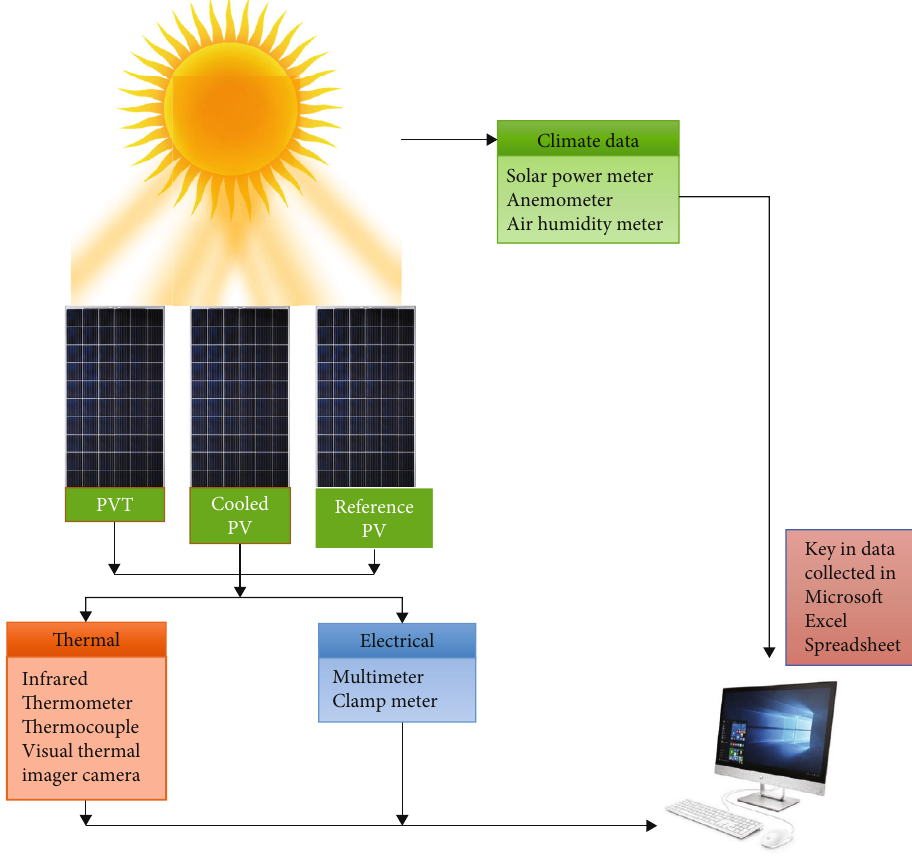
Figure 3: Schematic diagram of the experimental